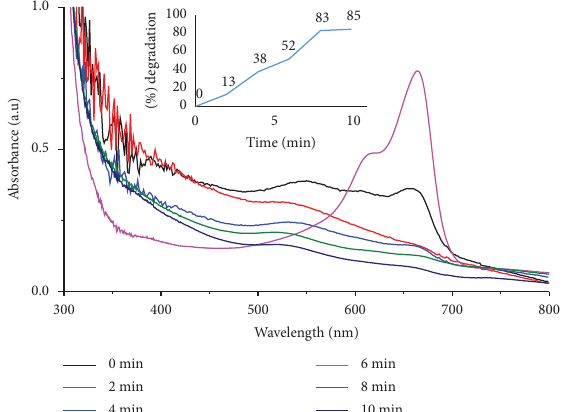
Figure 7: Photocatalytic degradation of methylene blue using cellulose/MoS